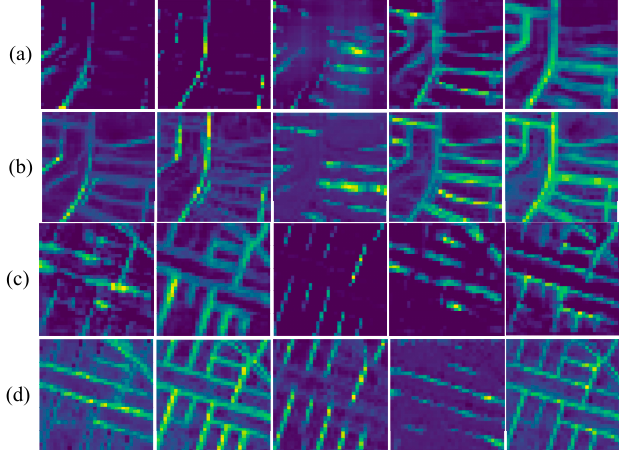
Figure 12. A visualization of different channels’ features. Samples ( a , b ) are features extracted by the encoding part in D-Linknet. Samples ( c , d ) are extracted features after introducing GC-block.